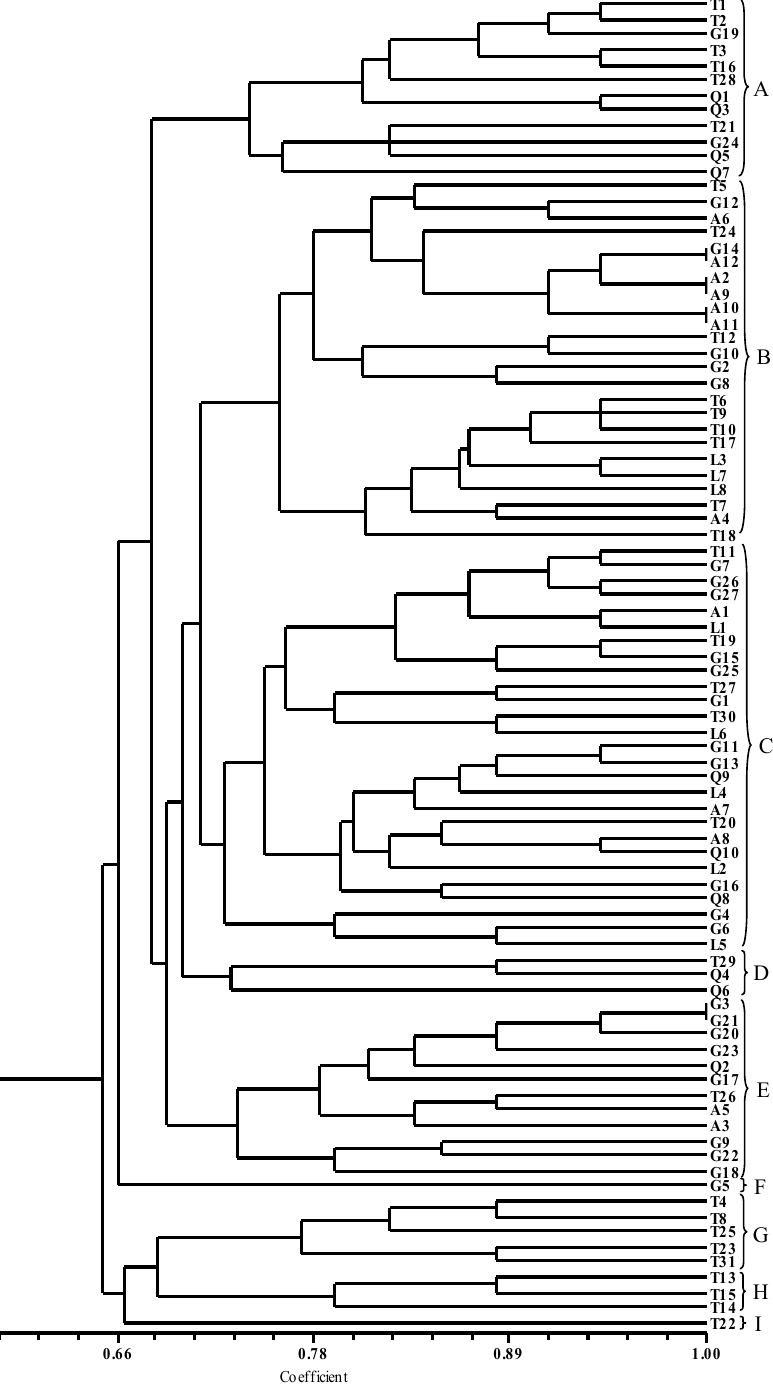
Figure 3. UPGMA analysis of 88 Fusarium culmorum isolates based on combined SSR data analysed using Nei and Li’s similarity coefficient (Nei and Li, 1979). Isolate numbers contain the province from which they were collected: T (Tehran), G (Golestan), A (East Azarbaijan), Q (Qazvin) and L